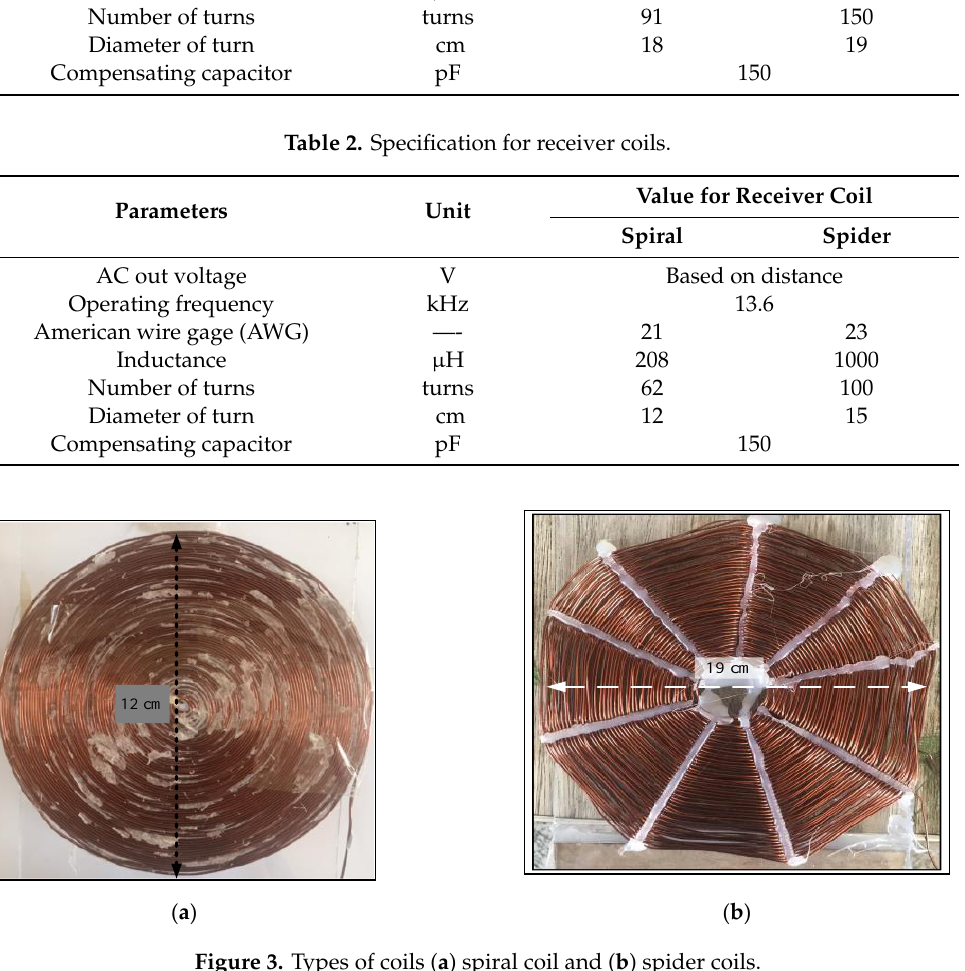
Figure 3. Types of coils ( a ) spiral coil and ( b ) spider coils.